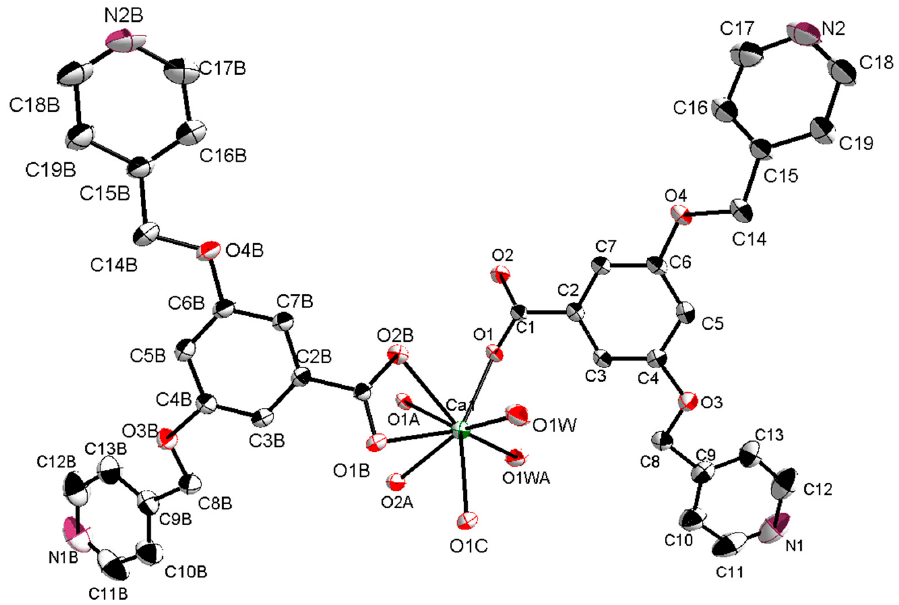
Figure 1. The coordination environment of Ca(II) ion.